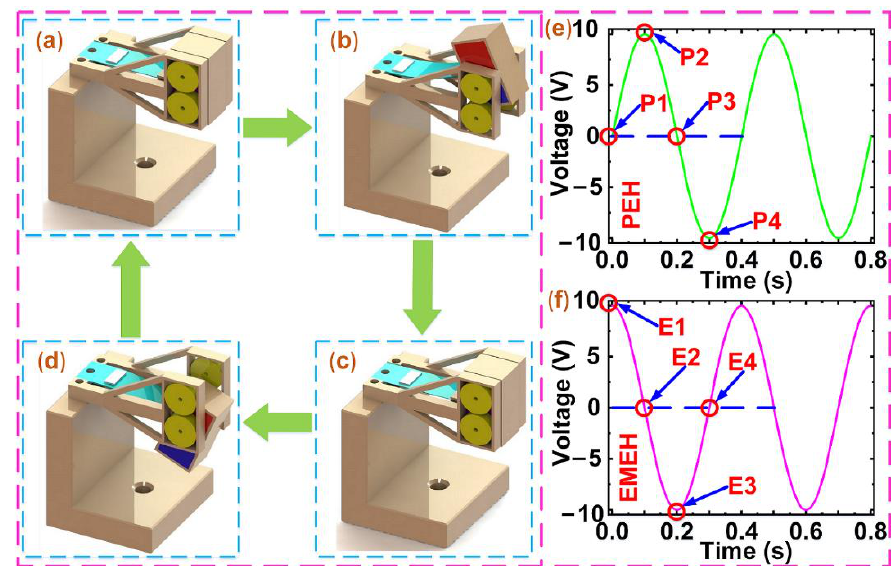
Figure 2. The positions of the cantilever beam in the reciprocating motion of the proof mass. ( a ) The initial position. ( b ) The position of maximum upward displacement. ( c ) The initial position. ( d ) The position of maximum downward displacement. ( e ) The simulated voltage of the PEH. ( f ) The simulated voltage of the EMEH.